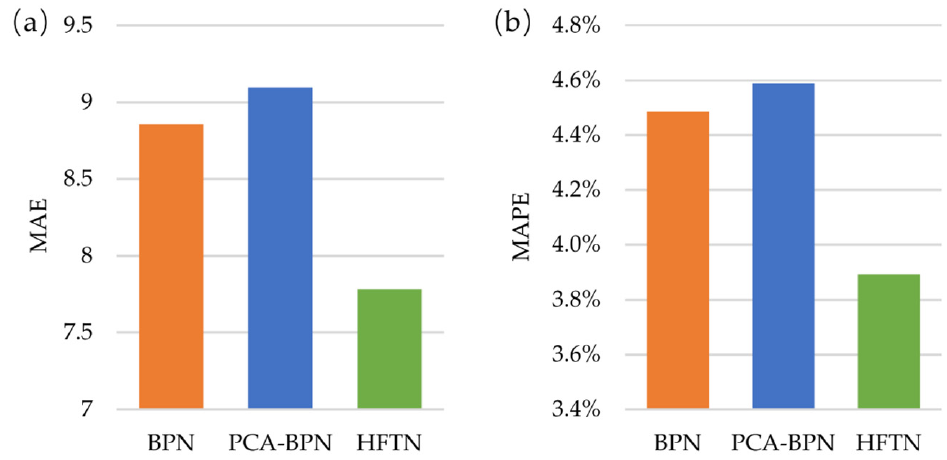
Figure 4. The CT prediction with three methods (BPN, PCA-BPN, and HFTN): ( a ) MAE analysis; ( b ) MAPE analysis.